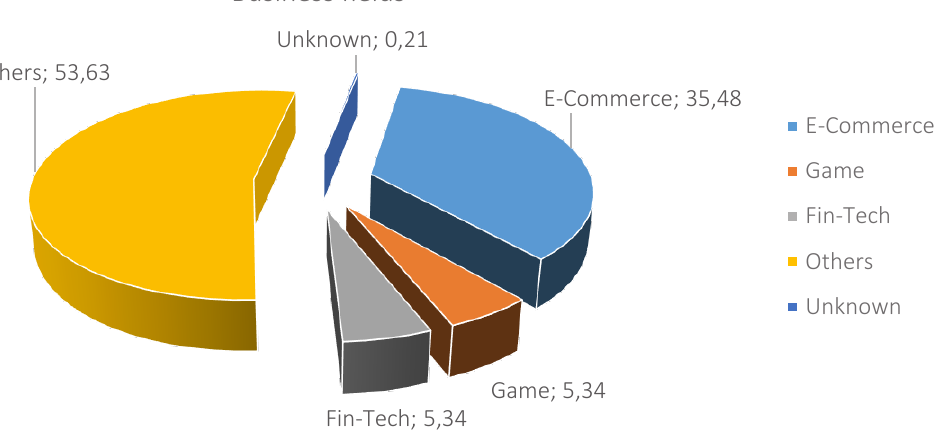
Figure 1. Distribution of startup business sectors in